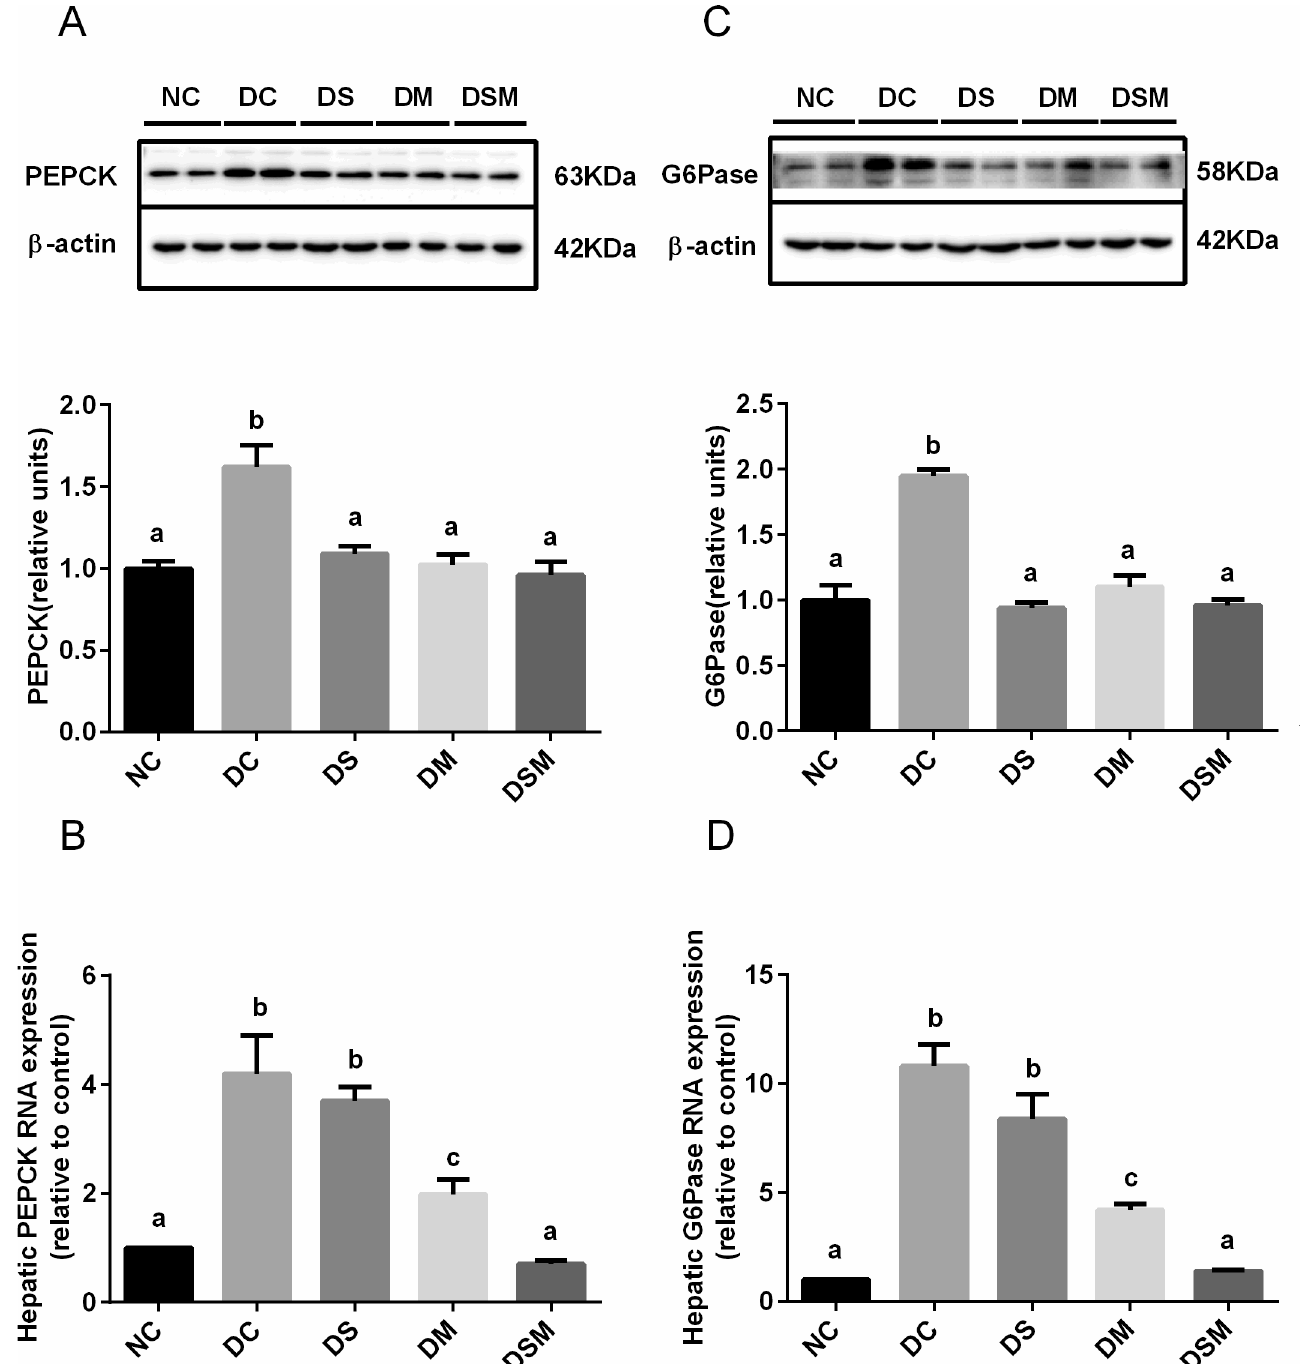
Fig 5. Combined intervention of swimming plus metformin suppresses hepatic gluconeogenesis under GDM condition. (A) Protein expression of PEPCK in the livers from the mice in NC, DC, DS, DM and DSM groups, respectively. Results were normalized to β -actin and the fold change was calculated relative to DC group. (B) mRNA levels of PEPCK in the same livers in (A). (C) Protein expression of G6Pase in the livers from the mice in NC, DC, DS, DM and DSM groups, respectively. Results were normalized to β -actin and the fold change was calculated relative to DC group. (D) mRNA levels of G6Pase in the same livers in (C). mRNA levels were normalized to β -actin. The values represent the mean ± SEM, n = 10/group. The columns with different letter (a, b, c) are significantly different, P < 0.05 (ANOVA, SNK). All data in this figure are representatives of three independent experiments. NC: normal control group, DC: GDM control group, DS: GDM treated with swimming group, DM: GDM treated with metformin group, DSM: GDM treated with swimming plus metformin group.